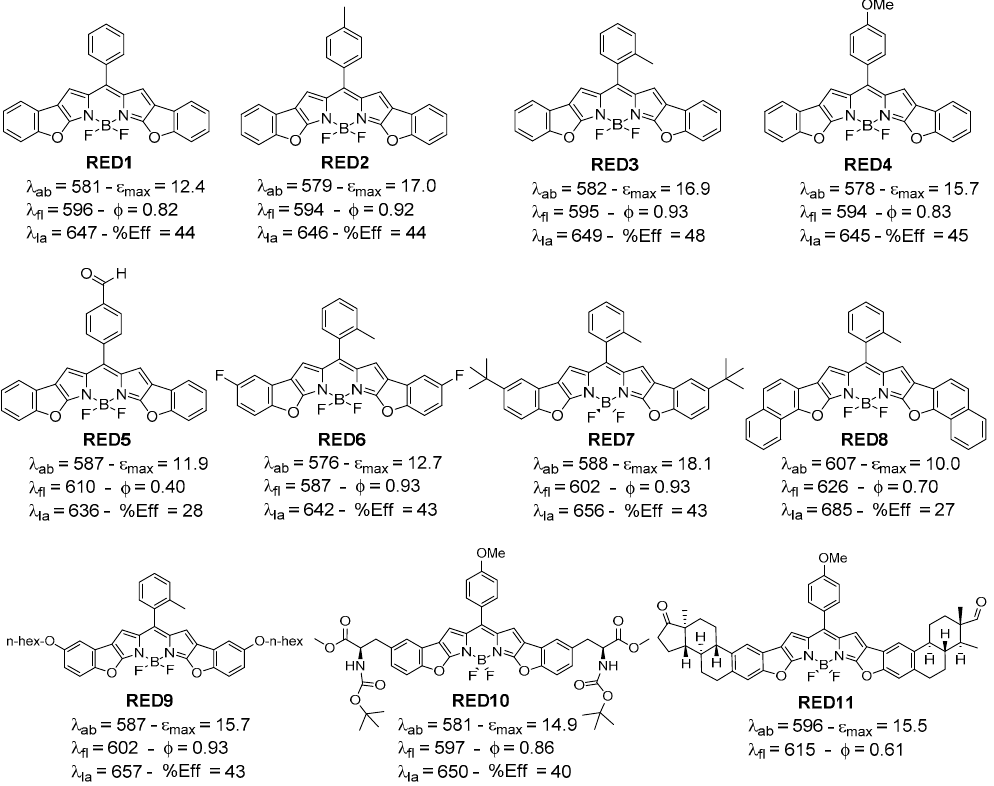
Figure 3. Molecular structures of the benzofuran-fused BODIPYs and their corresponding main photophysical (at diluted solutions of 2 µ M) and laser (at the optimal dye concentration ranging from 0.5 to 1.2 mM) data in ethyl acetate: absorption wavelength ( λ ab , in nm), molar absorption coefficient ( ε max , in 10 4 M − 1 · cm − 1 ), fluorescence wavelength ( λ fl , in nm), quantum yield ( φ ), laser wavelength ( λ la , in nm), and efficiency (% Eff). The laser emission of RED11 could not be recorded due to lack of solubility at the required high concentration.